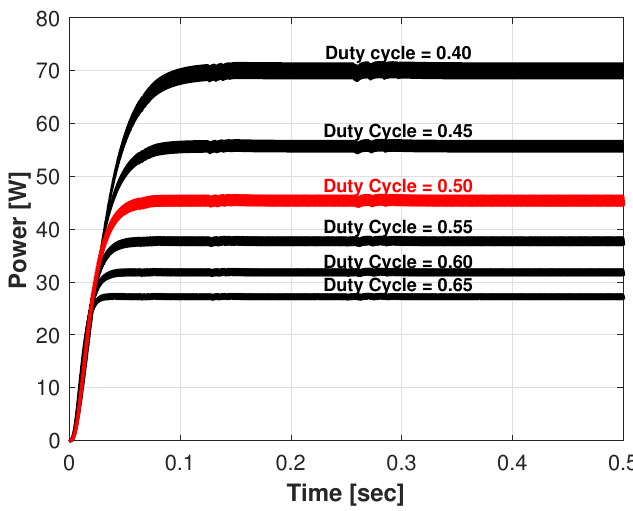
Figure 9. Power against time profiles with different duty cyle values, for the converter in Table 1.